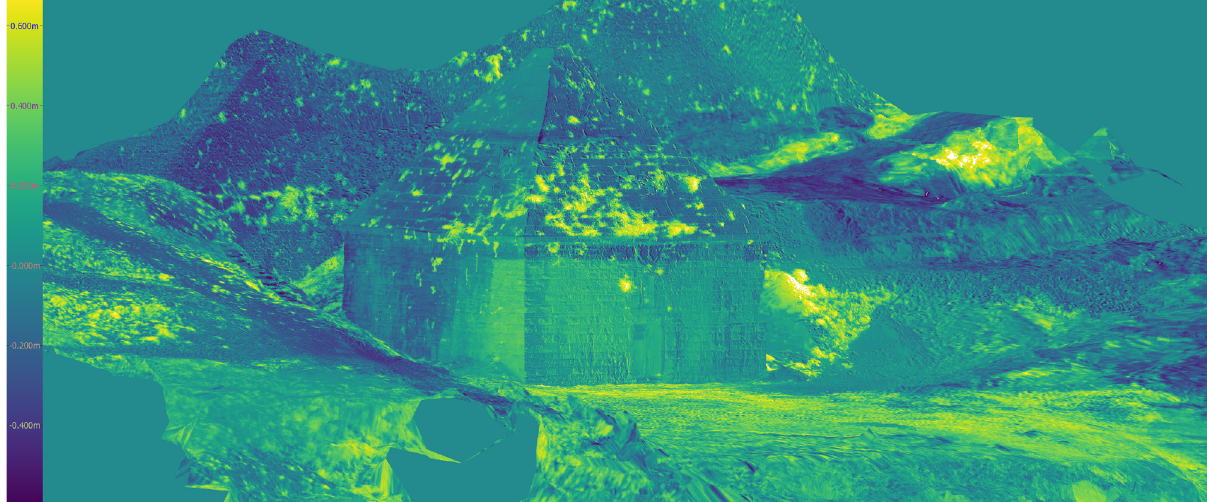
Figure 7. The metric model with NDVI mapping reconstructed from multispectral data processing acquisition with Low-Cost sensors if correctly processed. The effective and correct processing of data is therefore an essential element for a serious intervention of knowledge, documentation and preservation which cannot be ignored (fig.